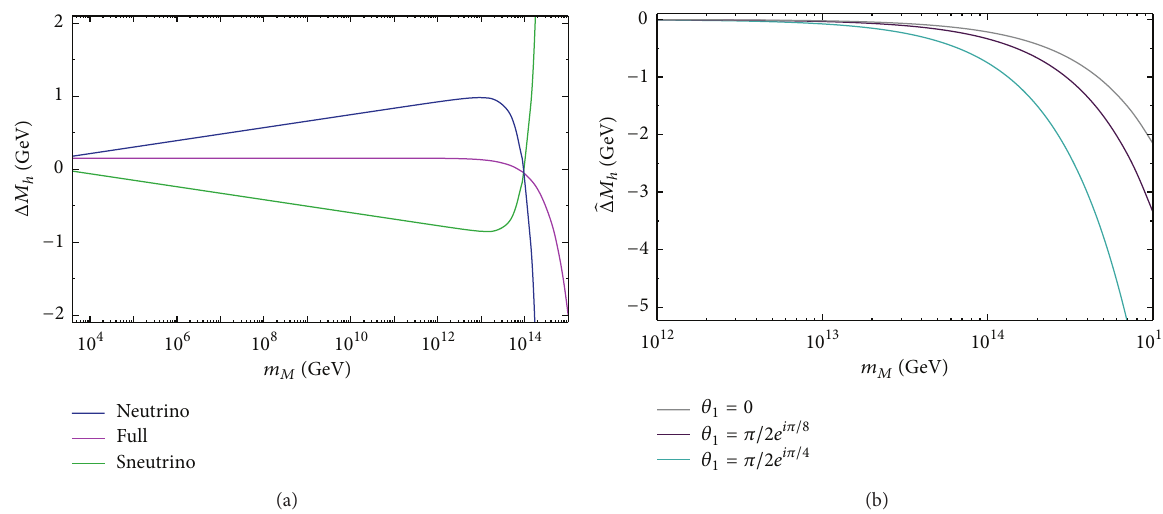
Figure 7: (a) Δ𝑀 ℎ as a function of 𝑚 𝑀 for degenerate heavy neutrinos and 𝑅 = 1. The corrections from neutrinos, sneutrinos, and the total are displayed separately. (b) set as in (79).